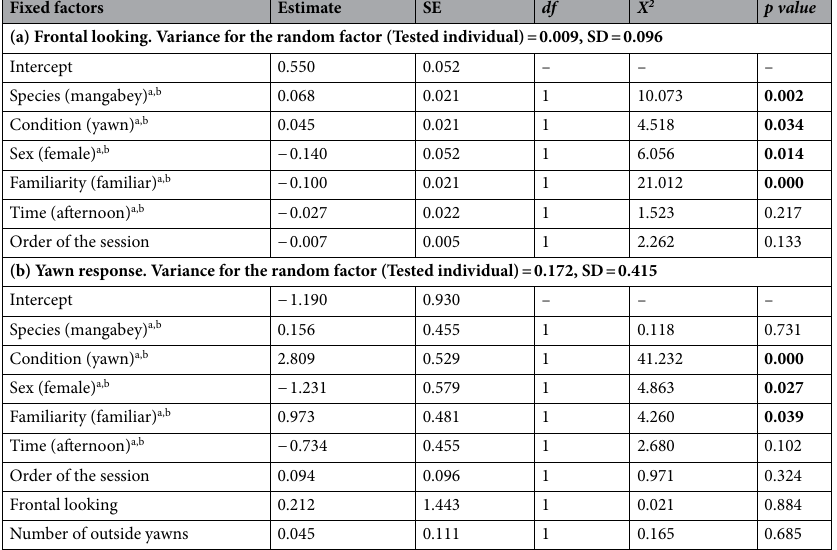
Model 2b . There was no difference between the full (fixed variables and interactions) and null model (X 2 11 = 14.617, P = 0.201). Similarly, no significant difference was found between the final full and null model (X 2 7 = 9.711, P = 0.206). During the 8-min block of each session the time spent performing SDBs scored low values (mean ± SE: 18.974 ± 2.130 s). This allowed us not to include SDB in Model 2c . Model 2c . The full model (fixed variables and interactions) significantly differed from the null one (X 2 11 = 55.098, P < 0.0001, R 2 marginal = 0.454, R 2 conditional = 0.491). Since all interactions were not significant (P Sex*Species = 0.832; P Sex*Condition = 0.329, P Familiarity*Species = 0.462; P Familiarity*Sex = 0.529), we ran the final GLMM excluding them. In Model 2c , the full model strongly differed from the null one (X 2 8 = 53.516, P < 0.0001; R 2 marginal = 0.444, R 2 conditional = 0.471). Sex , Condition , and Familiarity significantly affected the YR (Table 2b; Fig. 3a). The like- lihood of YR was more than 16 times higher in Yawn than Control condition (odds ratio = 16.60) (Fig. 3b).